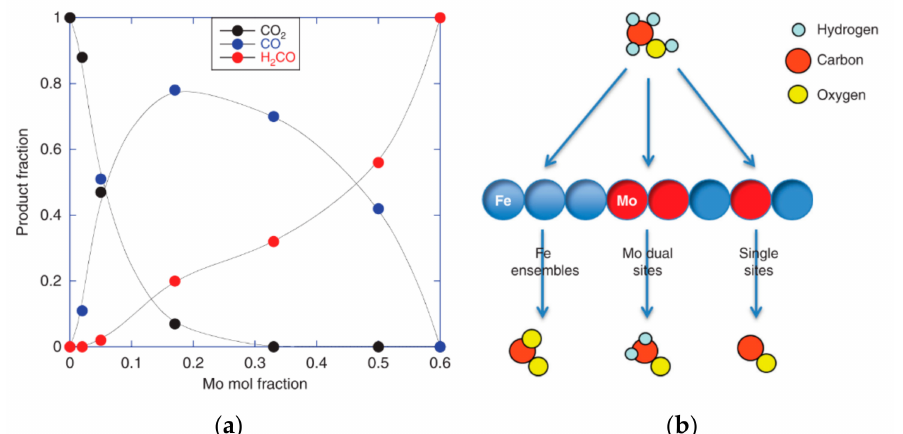
Figure 3. ( a ) Yields of CO, CO 2 , and FA from MeOH oxidation observed in TPD vs. Mo fraction in the catalyst (Mo mole fraction of 0.6 corresponds to Fe 2 (MoO 4 ) 3 ) [31]. ( b ) Model of the active sites on Fe-Mo oxide materials showing the variation in products from different site ensembles proposed by Bowker et al. [31]. Reproduced from [31] Copyright 2015, with permission from Taylor and